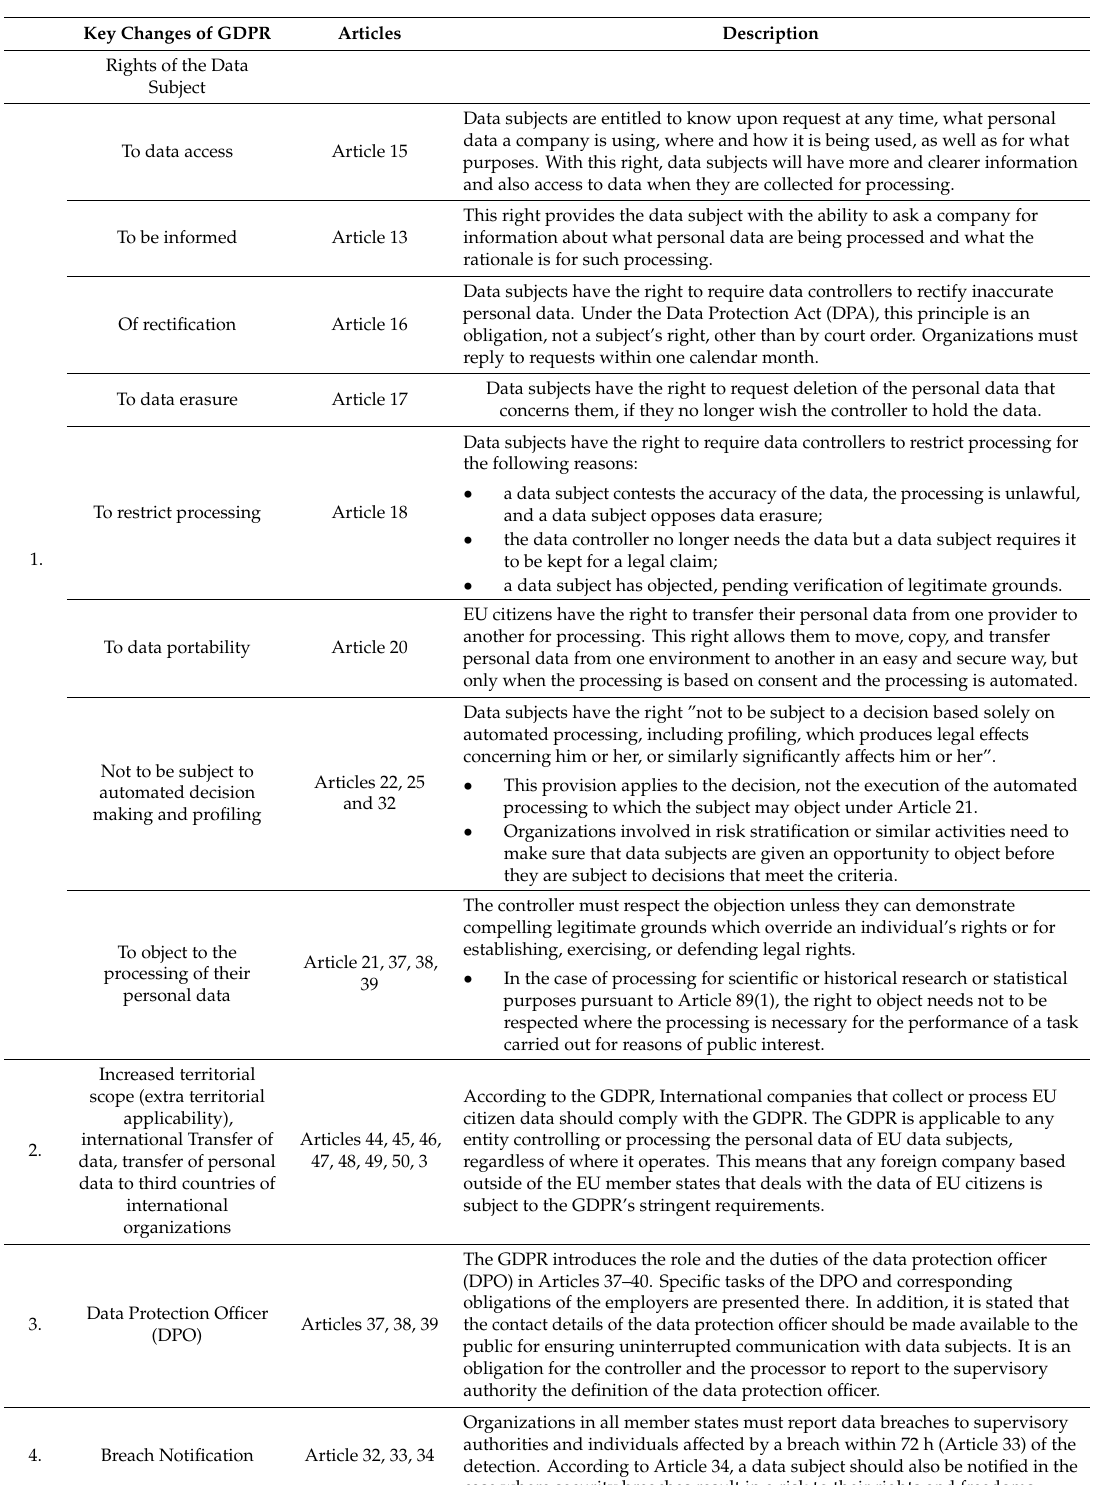
Table 1. Key changes of the General Data Protection Regulation (GDPR)